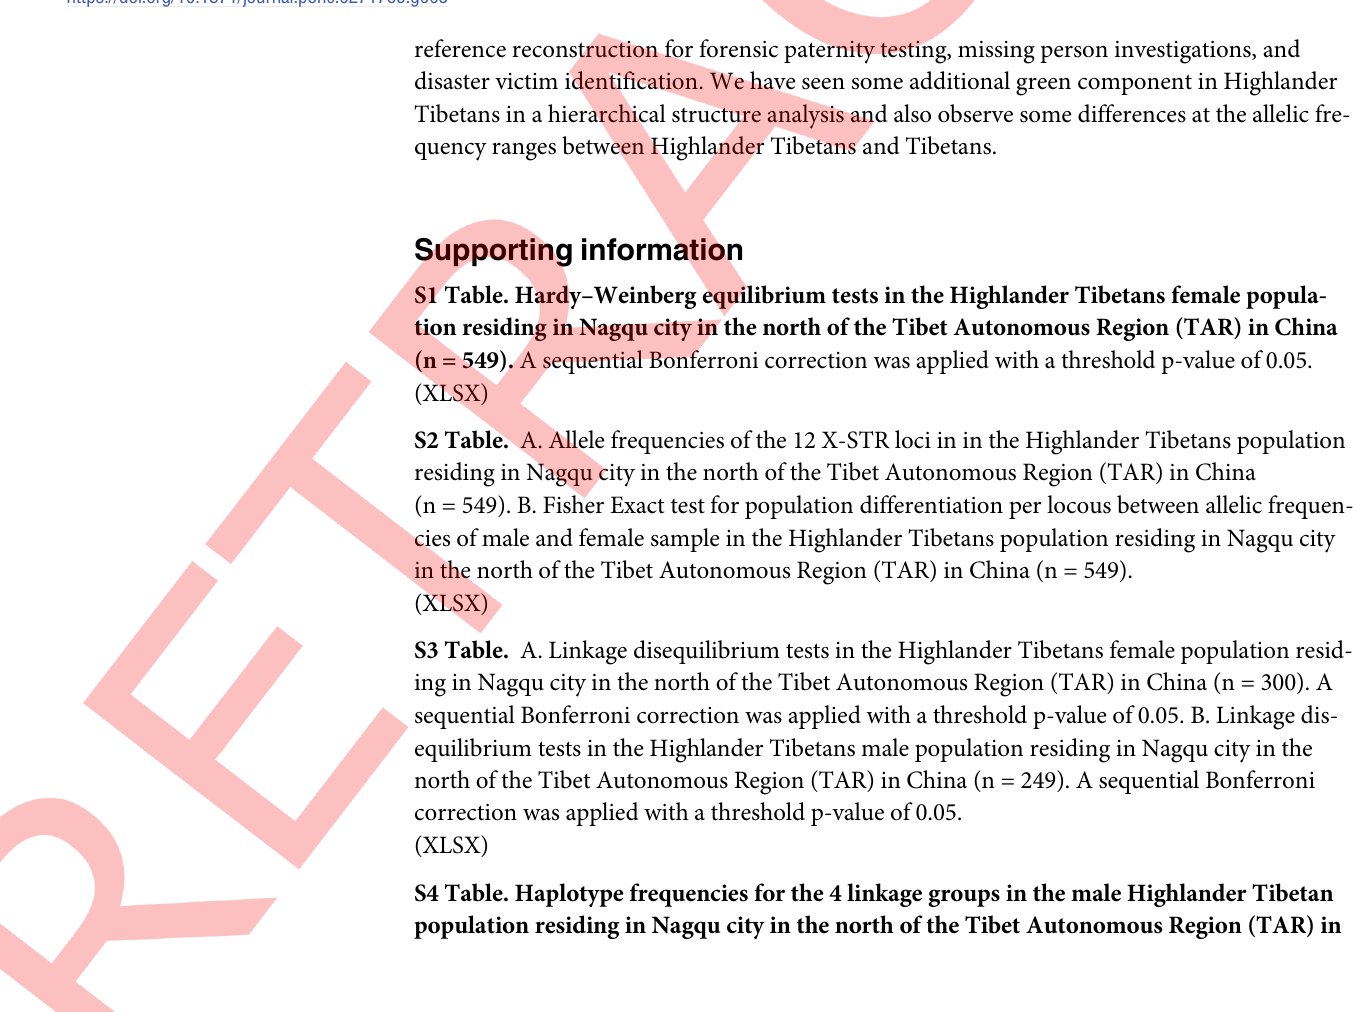
Fig 5. A neighbor-joining tree explaining the phylogenetic relationship of Highlander Tibetan and 16 other populations based on Nei’s genetic distances.